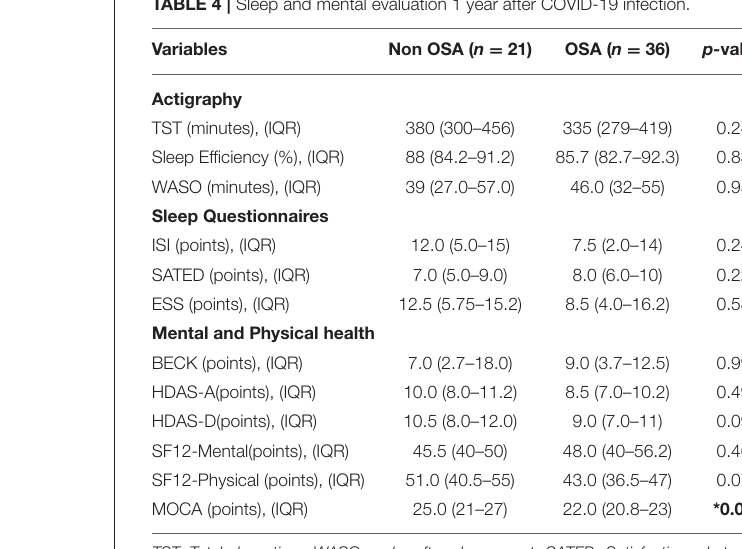
TABLE 4 | Sleep and mental evaluation 1 year after COVID-19